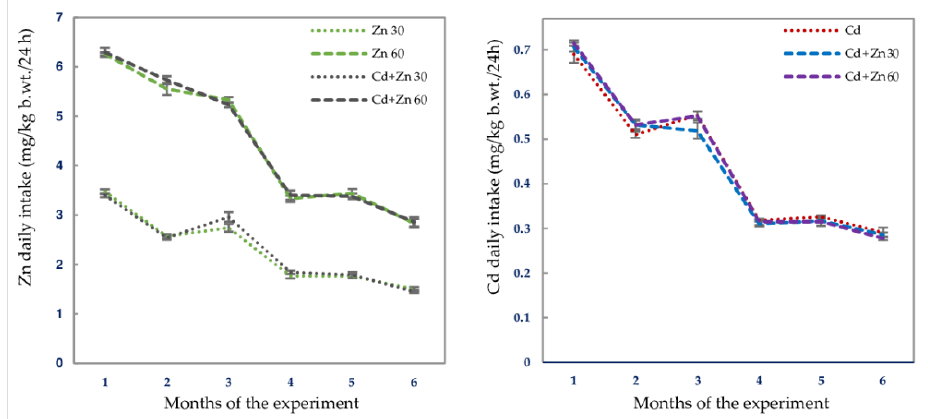
Figure 1. The mean daily intakes of zinc (Zn) and cadmium (Cd) in the subsequent months of their 6-month administration at the concentrations of 30 or 60 mg Zn/L and 5 mg Cd/L alone and together. Data represent mean ± standard error (SE) for 8 animals.